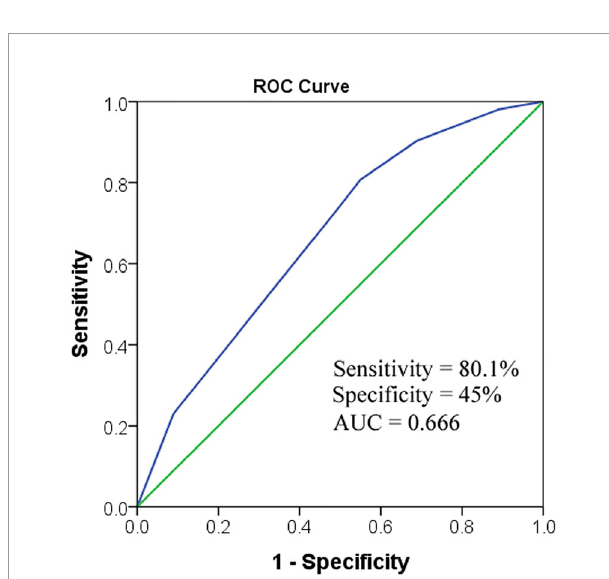
FIGURE 3 | ROC to predict BM. When combining the two factors together, AUC was 0.666. AUC, area under the curve; Dmax-T, greatest dimension of primary tumor; TRT, thoracic